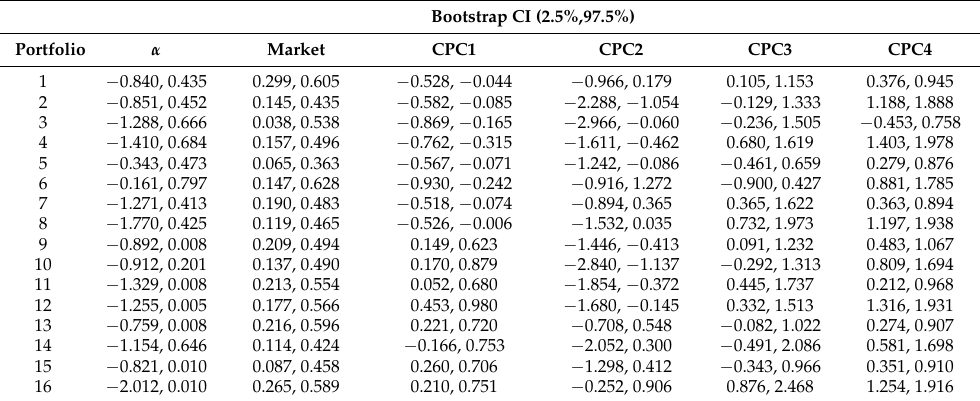
Table 10. Results for Bootstrap estimation of Model 2.